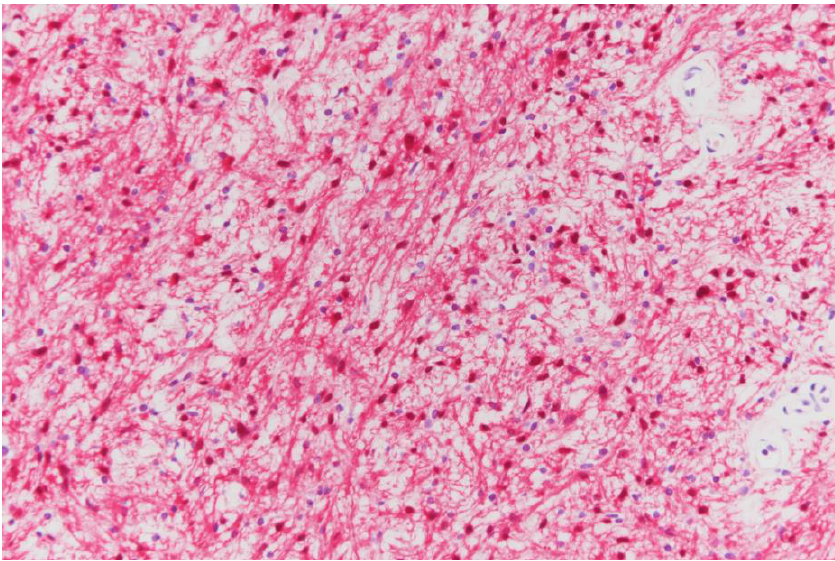
Figure 3. The immunohistochemical study shows diffuse strong-positive signaling for the S-100 pro- tein (200×